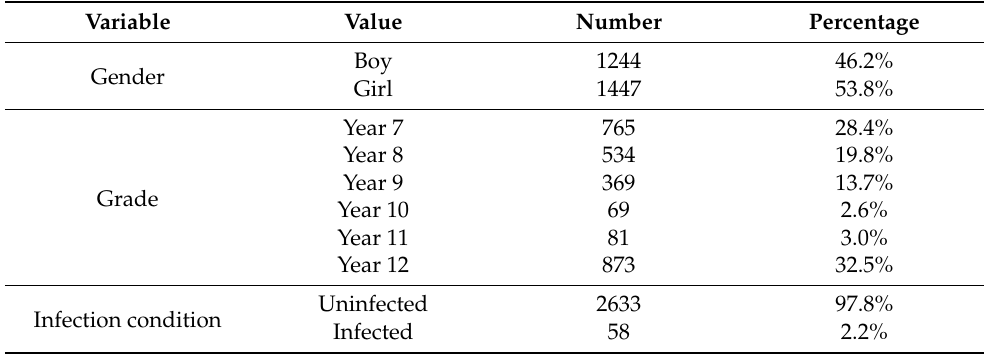
Table 1. Demographic information ( N = 2691).